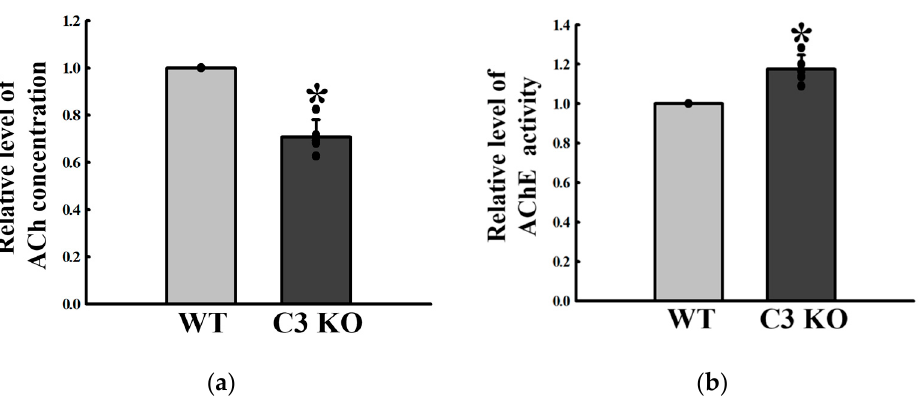
Figure 4. ACh concentrations and AChE activity in the mid colon of C3 KO mice. ( a ) ACh concentrations. The concentration of ACh was measured in the mid colon homogenate using an Acetylcholine Assay Kit. The minimum detectable concentration of this kit is 0.078–20 µM of ACh. ( b ) AChE activity. After homogenizing the mid colon tissue, the AChE activity was measured using an Acetylcholinesterase Assay Kit that could detect as little as 0.01 mU AChE in a 100 µL assay volume (0.1 mU/mL). Five mice per group were used to prepare tissue homogenate, and the ACh concentration and AChE activity were assayed in duplicate. Data are reported as the mean ± SD. * p < 0.05 compared to the WT group. Abbreviations: WT, wildtype; KO, knockout; ACh, acetylcholine; AChE, acetylcholinesterase.